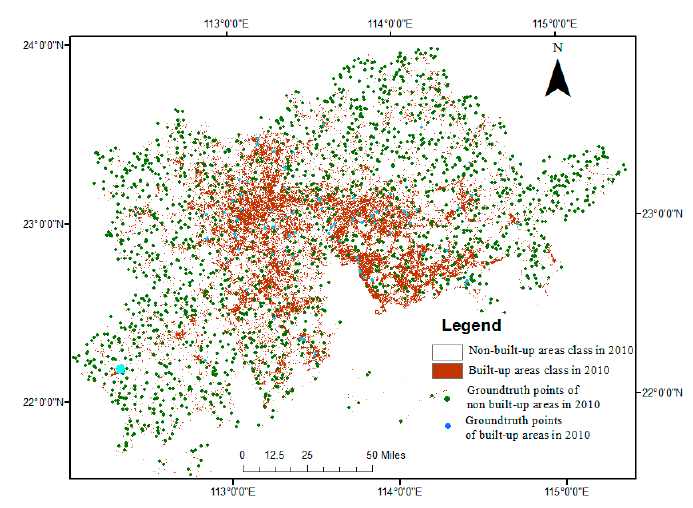
Figure 4. Location of samples selected in the PRD region in 2010.